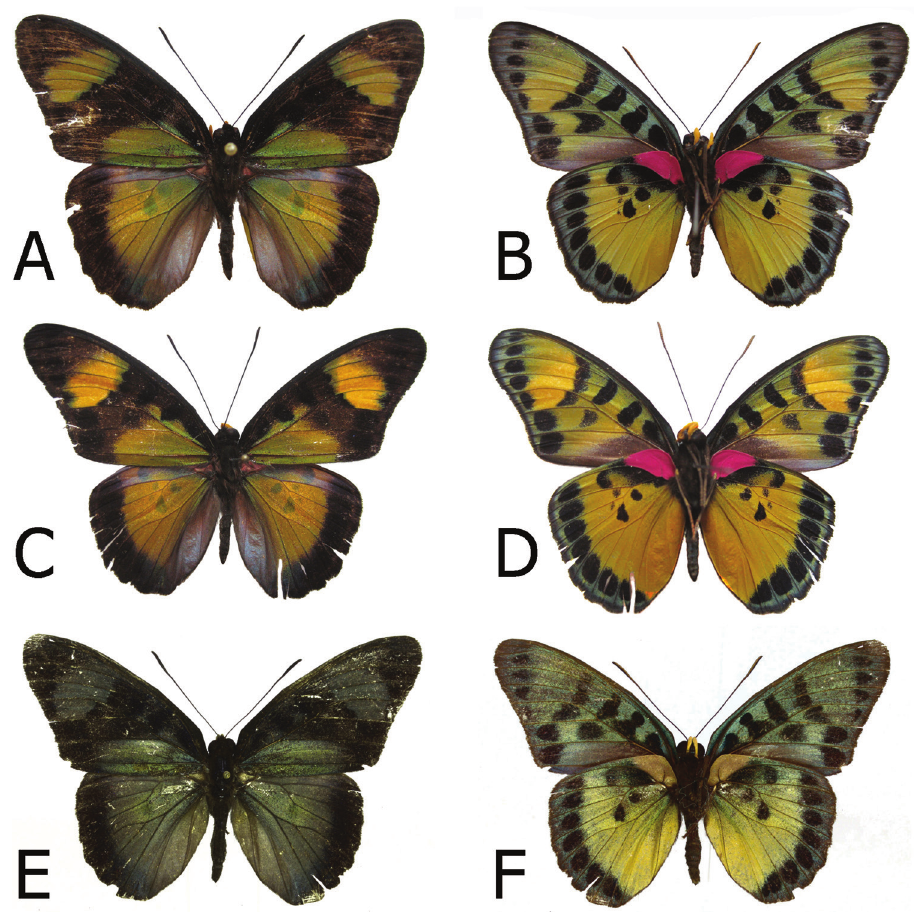
Figure 1. Adults, males: A Euphaedra cyparissa cyparissa Mount Swa, Liberia (dorsum) B Euphaedra cyparissa cyparissa Mount Swa, Liberia (venter) C Euphaedra cyparissa nimbina Mont Nimba, Guinea, holotype (dorsum) D Euphaedra cyparissa nimbina Mont Nimba, Guinea, holotype (venter) e Euphaedra cyparissa tai Tai, Ivory Coast (dorsum) F Euphaedra cyparissa tai Tai, Ivory Coast convex outer margin; most of wing surface black; costa from base to apex dusted with dark blue; a rich green area from wing base to two-thirds of anal margin, marginally en- tering discal cell along lower part and at base of cell Cu1-Cu; a large, roughly oval rich green subapical patch with a marginal bluish sheen, extending widely from subcosta costa to vein M3, with sharply defined zigzagging basal limit, with an incision along vein M3, and a diffused outer limit; fringes grey. HWD oval with a gently scalloped outer margin; rich green, with a golden yellow overcast in outer one-third, a black mar- ginal area gradually narrowing from roughly 4–5 mm at apex to 2 mm at tornus where heavily suffused with blue; fringes grey. FWV mostly bottle green, slightly lighter than on the FWD subapical patch, a series of large irregular black discal patches, at wing